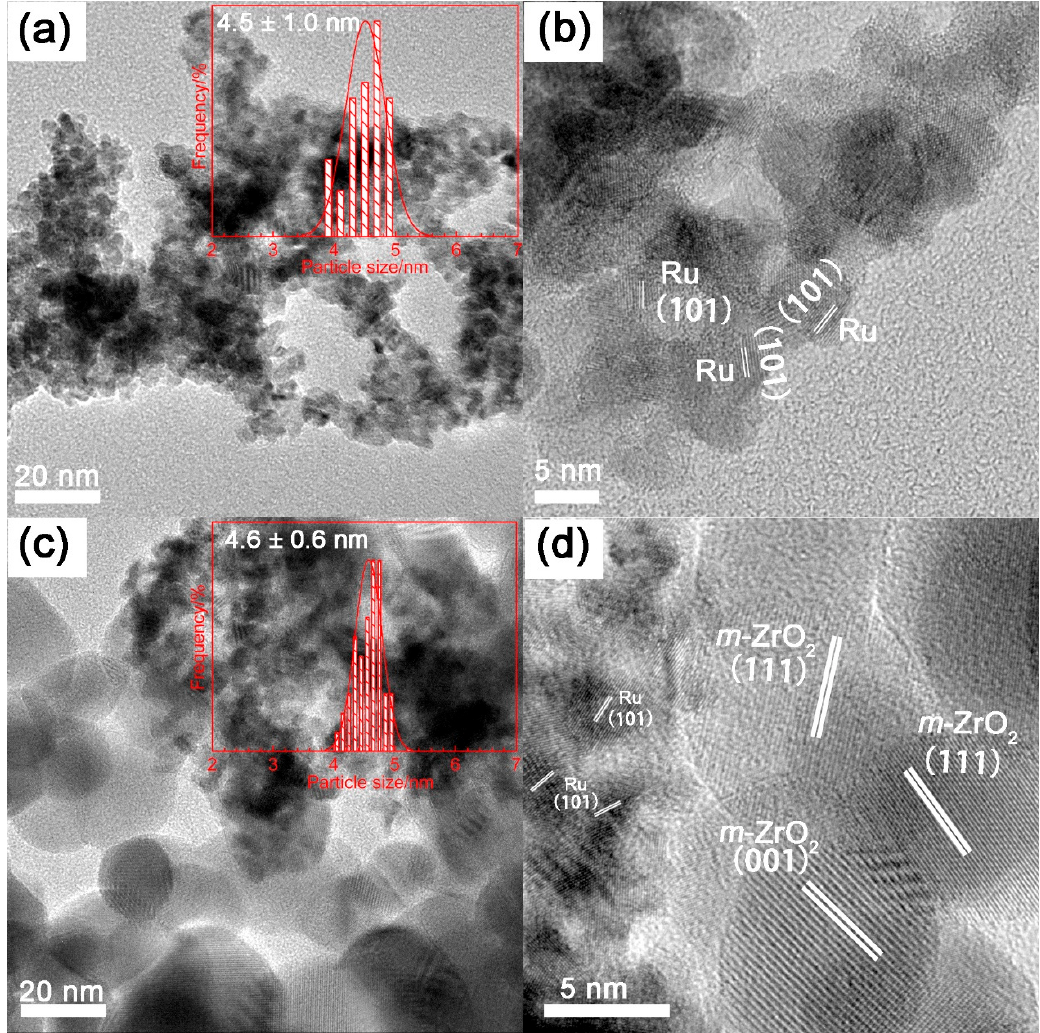
Figure 9. TEM images and Ru particle size distributions of the unsupported Ru-Zn (0.60) catalyst with m-ZrO 2 as the dispersant before ( a , b ) and after ( c , d ) catalytic experiments. XPS profiles of the unsupported Ru-Zn (0.60) catalyst with m-ZrO 2 as the dispersant after